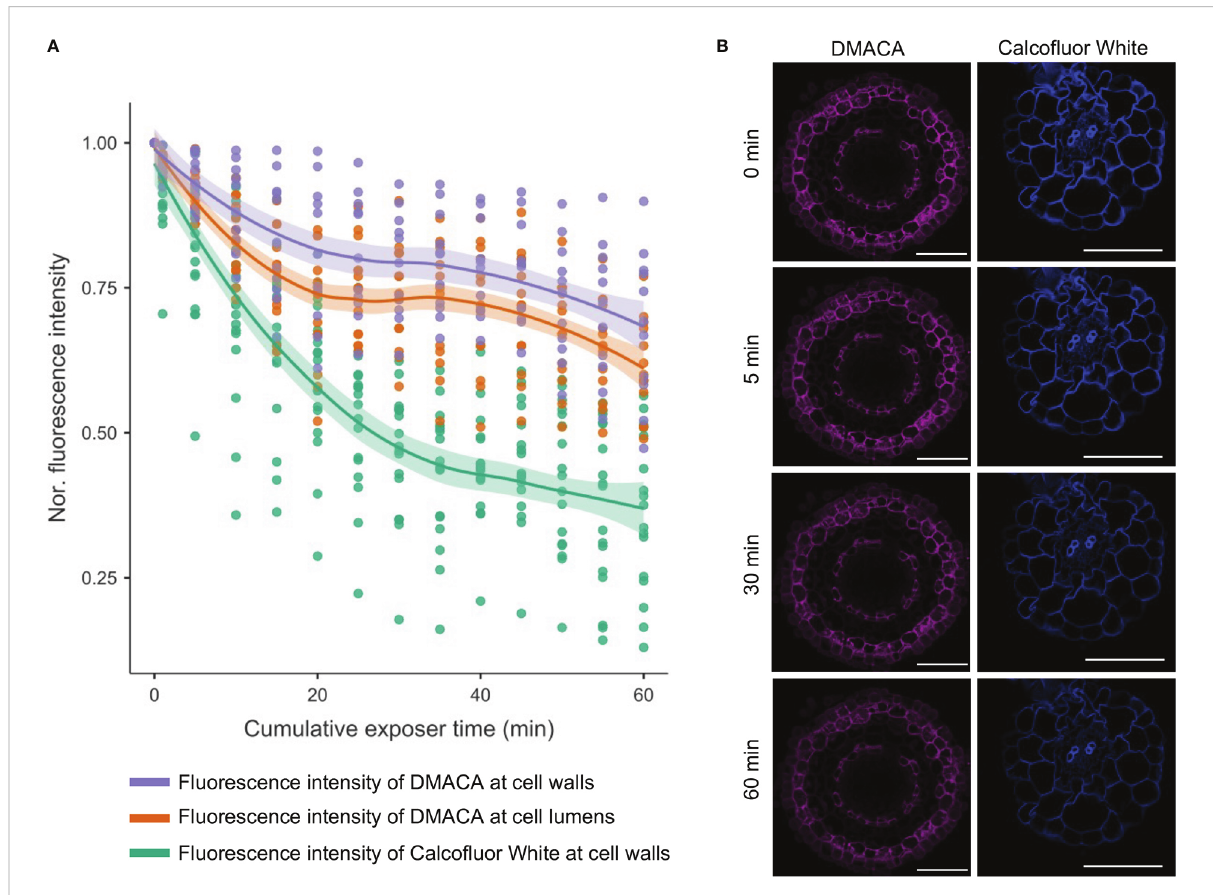
FIGURE 4 Photobleaching curves for Calco fl uor White (excited with a 405 nm laser) and DMACA (excited with a 633 nm laser) stained poplar roots. (A) Line graph showing the average signal intensity of various areas of plant cells normalized to the signal at timepoint zero. The shaded areas represent 95% con fi dence intervals. (B) Micrographs of poplar root cross-sections at 0, 5, 30 and 60 minutes after scanning, showing photobleaching of samples stained with DMACA and Calco fl uor White. The laser gain was slightly different for the two lasers but was maintained constant over time. All other scan parameters were the same for the two laser lines. Scale bars = 50